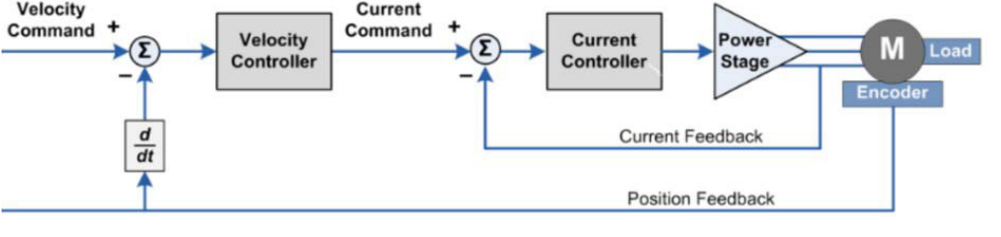
Figure 5. Typical servo